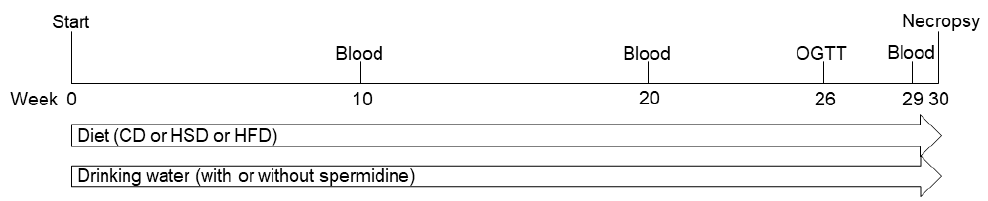
Figure 1. Experimental design. OGTT, oral glucose tolerance test; CD, control diet; HSD, high sucrose diet; HFD, high fat diet.